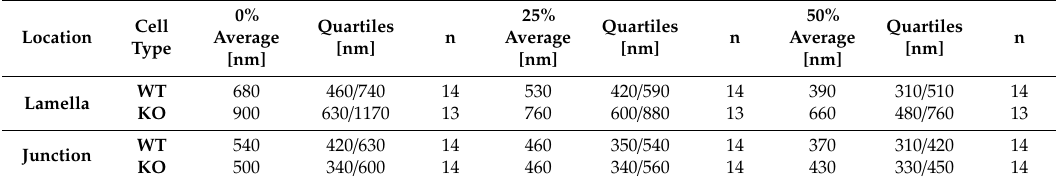
Table 2. Dependence of indentation depths on strains.